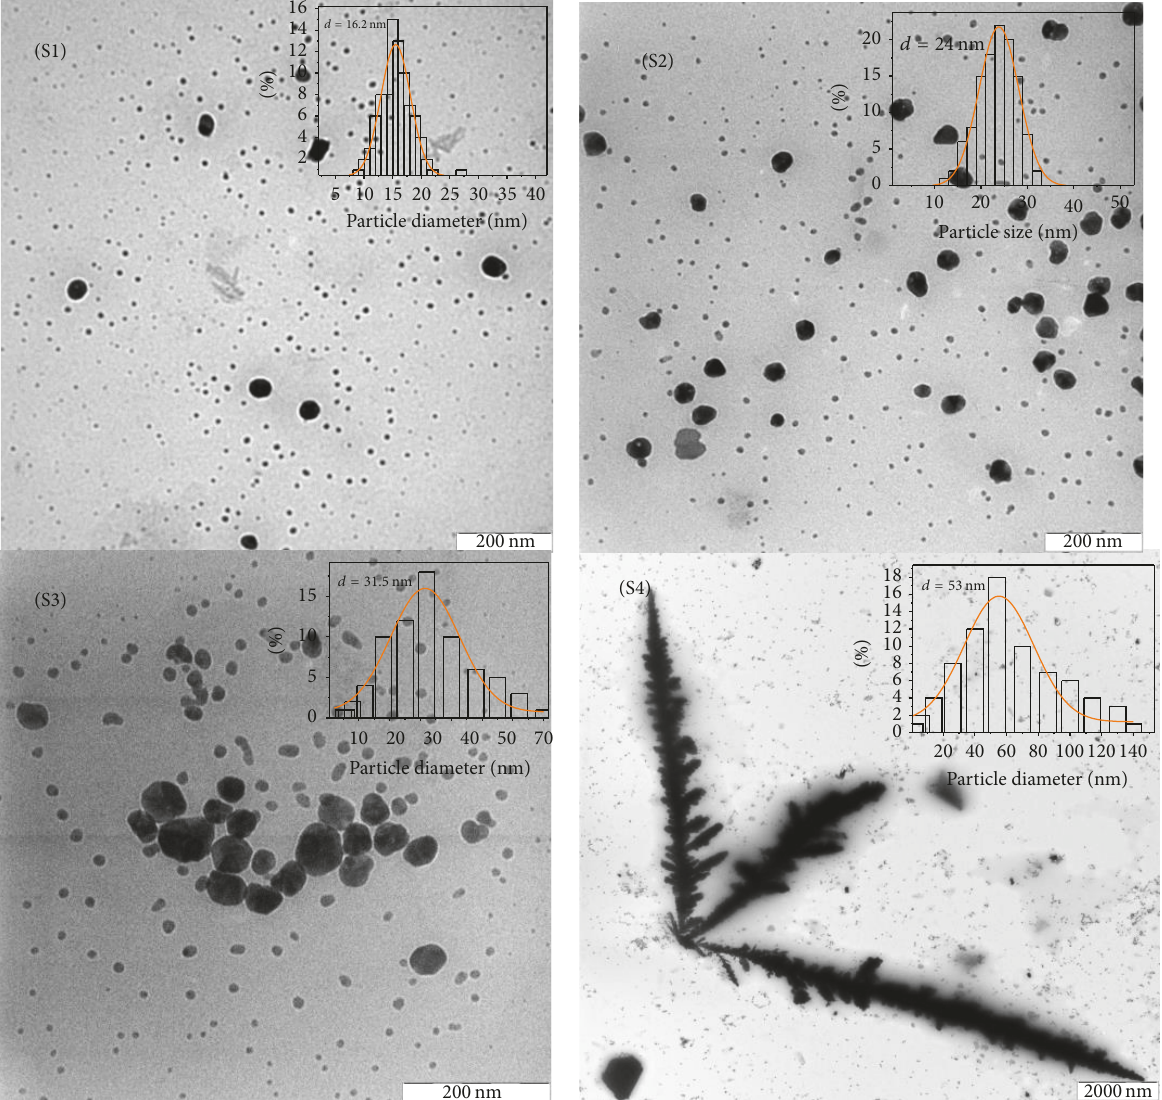
Figure 4: The TEM images and size distributions of the four particle diameters obtained at different MI times, (S1) 16, (S2) 24, (S3) 31, and (S4) 53